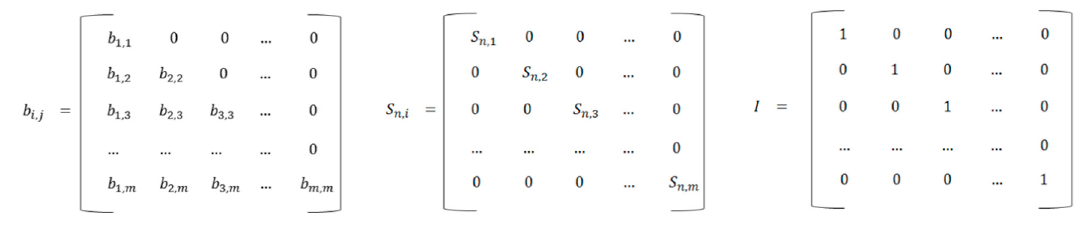
Figure 6. Notation of the breakage function, the selection function and the identity matrix.